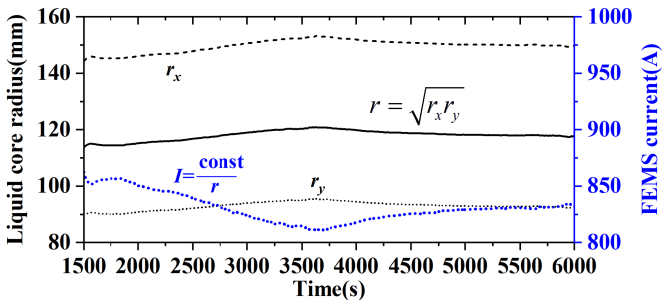
Figure 14. Dynamic control of FEMS current.